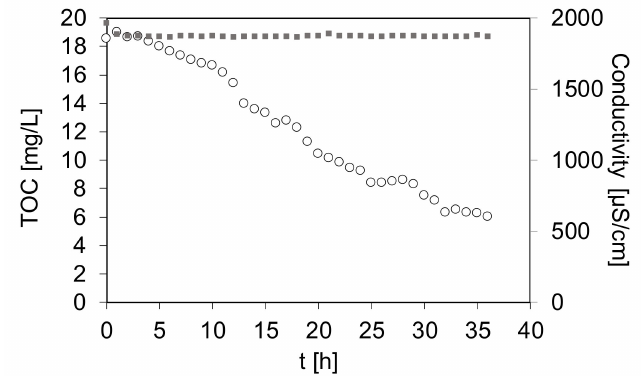
Figure 3. Mineralization of organic contaminants measured as TOC and changes of e ffl uent conductivity during UV / O 3 process with in situ formed O 3 applied to the wastewater pretreated in